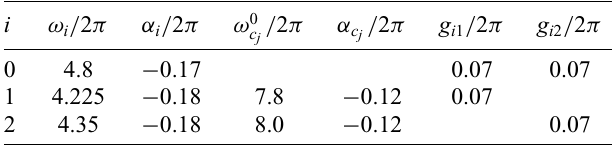
TABLE I. Parameter values used in Eq. (49) for the simulations of implementing CCZS gates with tunable couplers. Here, ω 0 the maximum frequency of coupler j . All values are given in units of